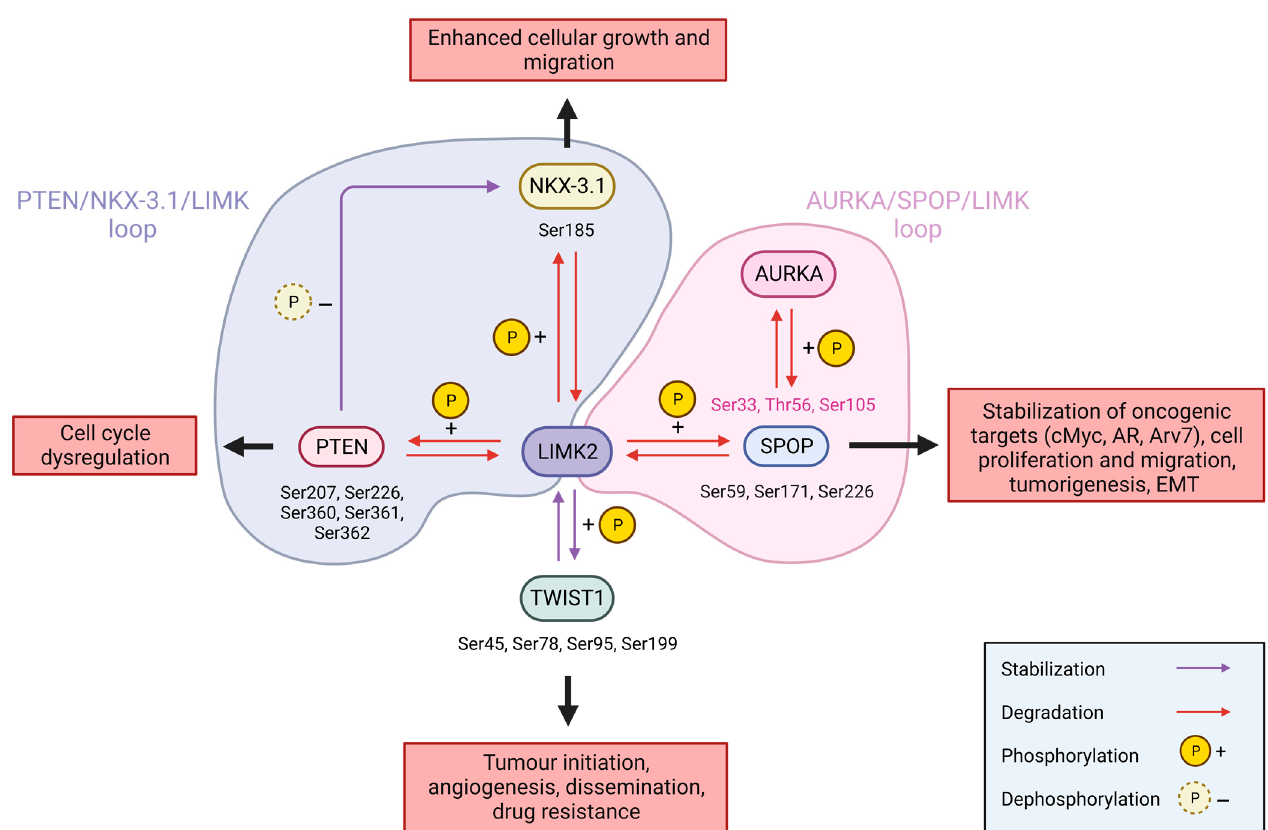
Figure 6. LIM2 molecular implication in prostate cancer. PTEN/KNX-3.1/LIMK and AURKA/SPOP/LIMK feedback loops are depicted with blue and pink areas, respectively. PTEN sites phosphorylated by LIMK2 (Ser207, Ser226, Ser360, Ser361, and Ser362), TWIST1 sites phosphorylated by LIMK2 (Ser45, Ser78, Ser95, and Ser199), as well as SPOP sites phosphorylated by LIMK2 (Ser59, Ser171, and Ser226), and NKX-3.1 site phosphorylated by LIMK2 (Ser185) are mentioned in black. SPOP sites phosphorylated by AURKA (Ser33, Thr56, and Ser105) are mentioned in pink.